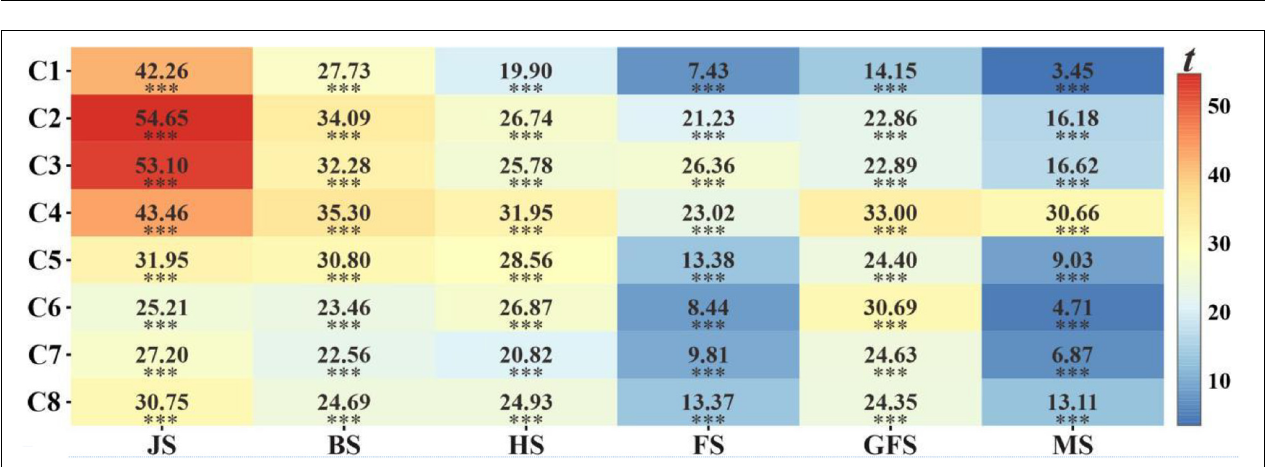
FIGURE 10 | Results from paired t -test between model R 2 obtained from the EWF method and the individual stages. ∗∗∗ significant at P ≤ 0.001; JS, jointing stage; BS, booting stage; HS, heading stage; FS, flowering stage; GFS, grain filling stage; MS, maturity stage.